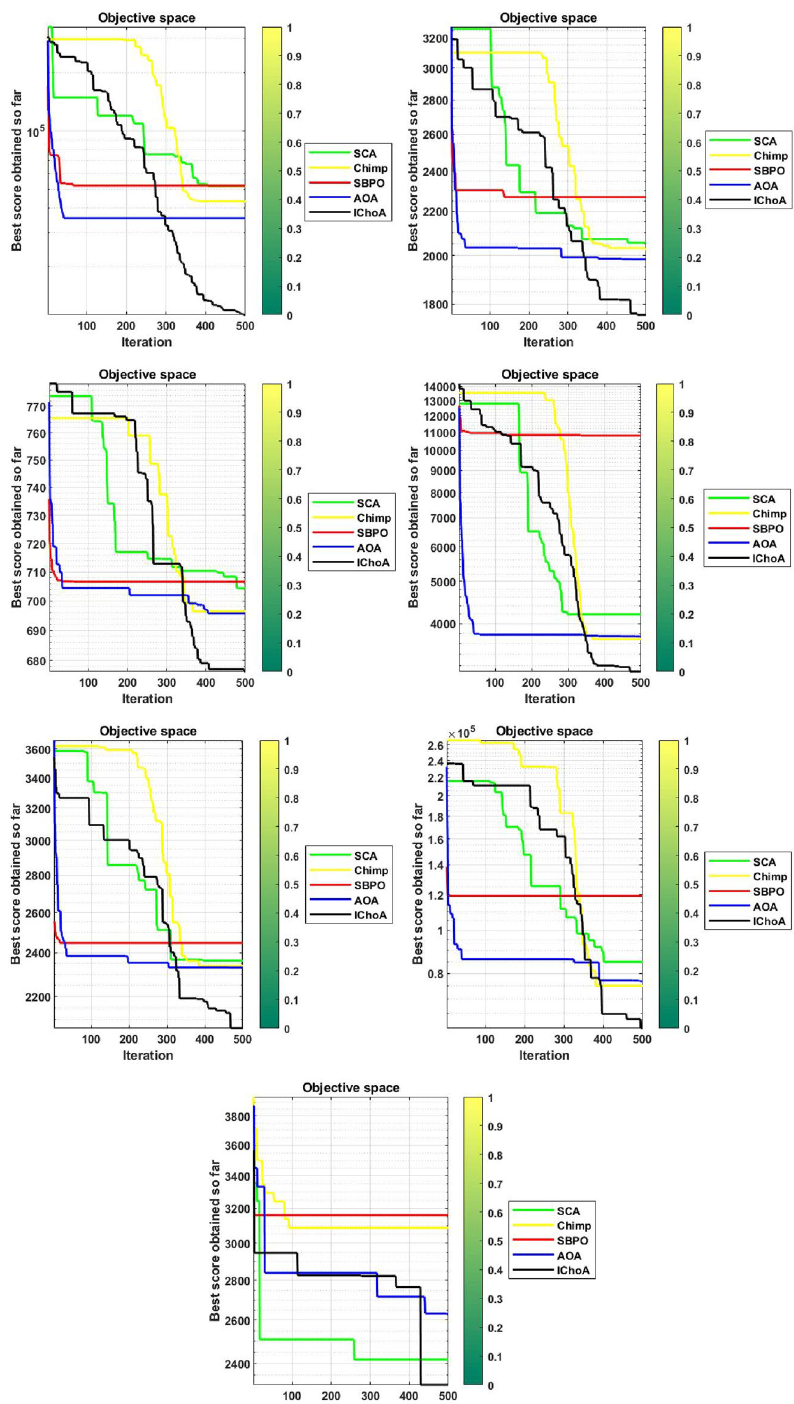
Figure 4. Convergence graphs of evolutionary algorithms on simple-multimodal test